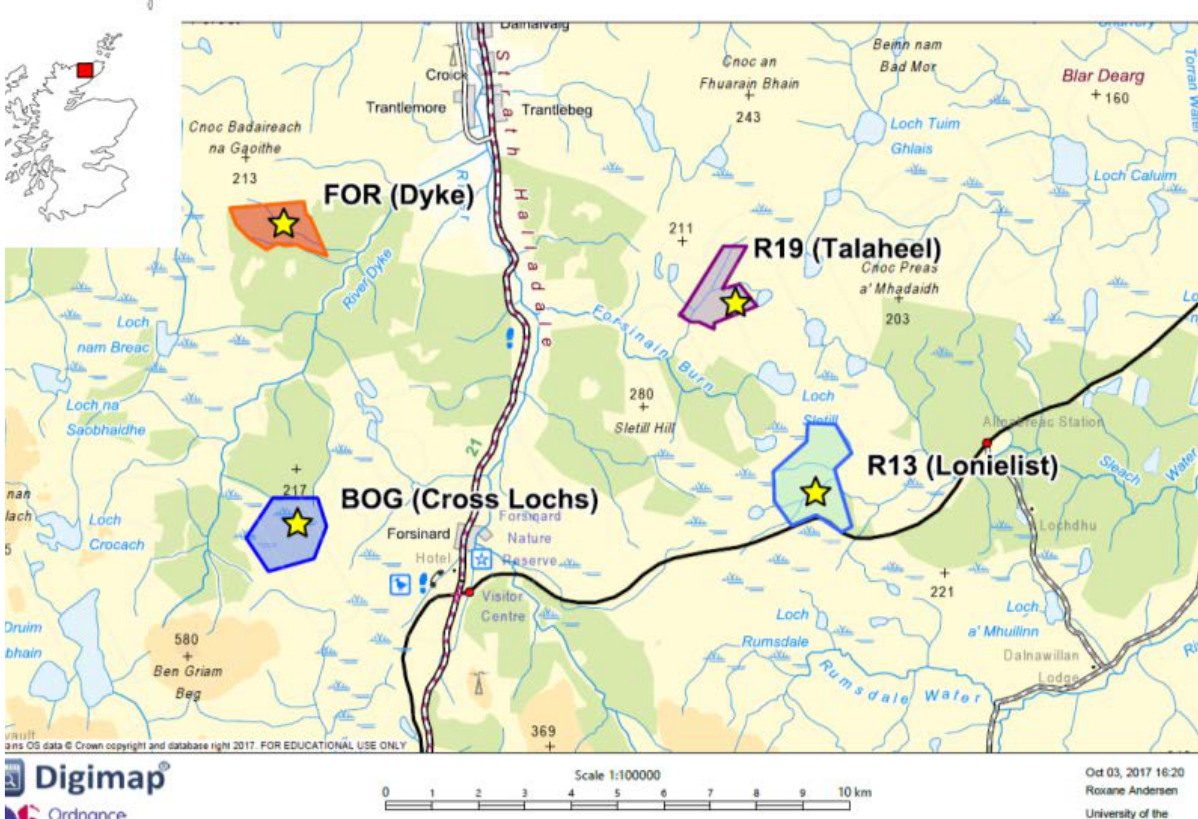
Figure 1. Map showing the four areas (BOG, R13, R19 and FOR) sampled for the study, with stars indicating location of eddy flux covariance tower for measuring GHG emissions. Insert shows location of the study area in